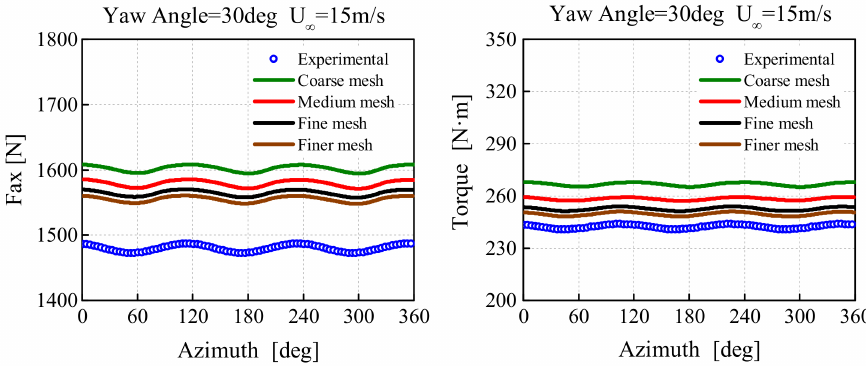
Figure 3. Grid dependency study at the inflow velocity of 15 m/s, TSR = 6.7.